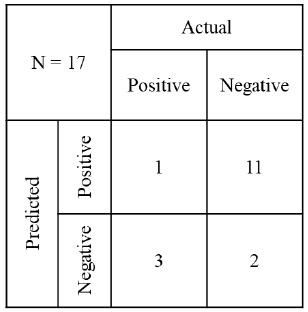
Fig. 6: Confusion matrix of the prediction of the prolonged labor for the test